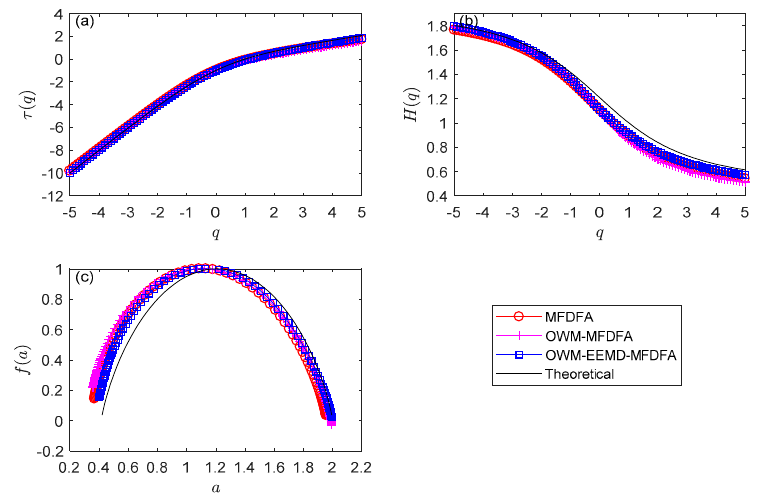
Figure 2. The plots of ( a ) τ ( q ) ∼ q , ( b ) H ( q ) ∼ q and, ( c ) α ∼ f ( α ) of the multifractal detrended fluctuation analysis (MFDFA), overlap moving window (OWM)-MFDFA, and OWM- ensemble empirical mode decomposition (EEMD)-MFDFA methods with the theoretical values (continuous black line)